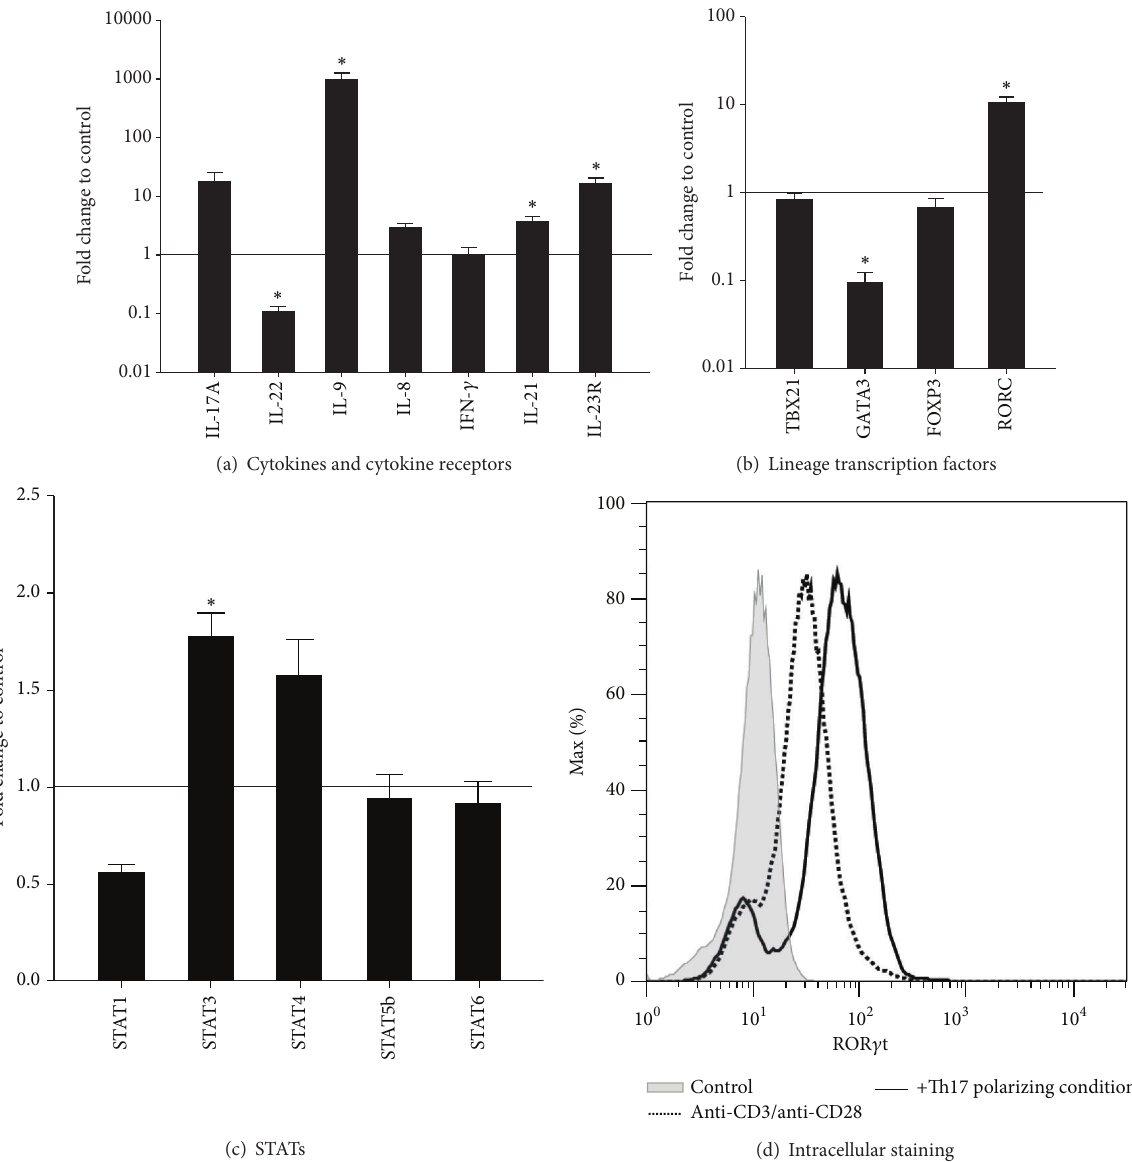
Figure 4: Effect of Th17 polarizing conditions on the mRNA expression and ROR 𝛾 t protein expression of CD4 + T cells. Human CD4 + T cells were cultured with anti-CD3/anti-CD28 in the presence or absence of Th17 polarizing conditions for 5 days. (a–c) The mRNA expression of the indicated genes was measured by real-time PCR. Data were normalized to the mean of the reference genes GUSB, PPIA, PGK1 , and the mRNA expression at day 0 using the ΔΔ Ct-method. Fold changes in gene expression of CD4 + T cells with Th17 polarizing conditions compared to control without Th17 polarizing conditions (black line) are represented as mean and SEM. ∗ represents significance, 𝑃 < 0.05 , Mann-Whitney 𝑈 test, and 𝑛 = 7 . (d) After restimulation with PMA, Ionomycin and Monensin for five hours and fixation/permeabilization the cells were stained for CD4 and ROR 𝛾 t and analyzed by flow cytometry. The ROR 𝛾 t histogram refers to gated CD4 + T cells. Unstained cells were used as control, 𝑛 = 2